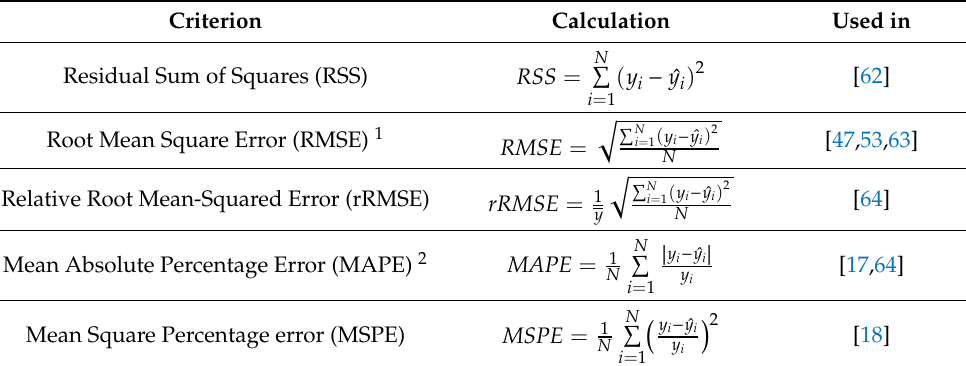
Table 3. Fitness criteria used in various studies for BMP testing. Criterion